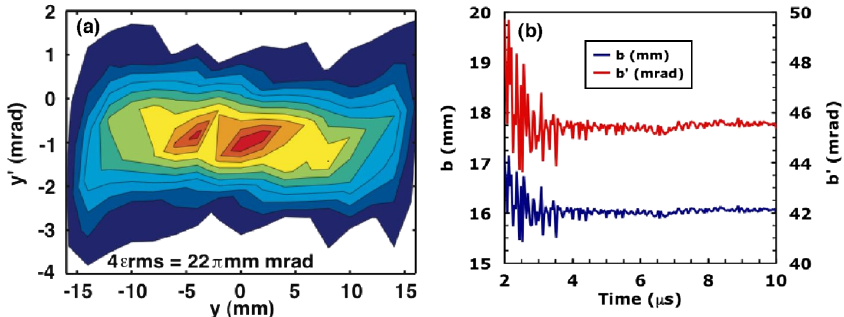
FIG. 3. (Color) (a) Sheared phase-space distribution integrated over a 500 ns gate in the middle of the 10 (cid:1) s beam pulse; (b) beam envelope as a function of time 15 cm downstream of the exit of the extractor ( z (cid:6) 27 cm ; no